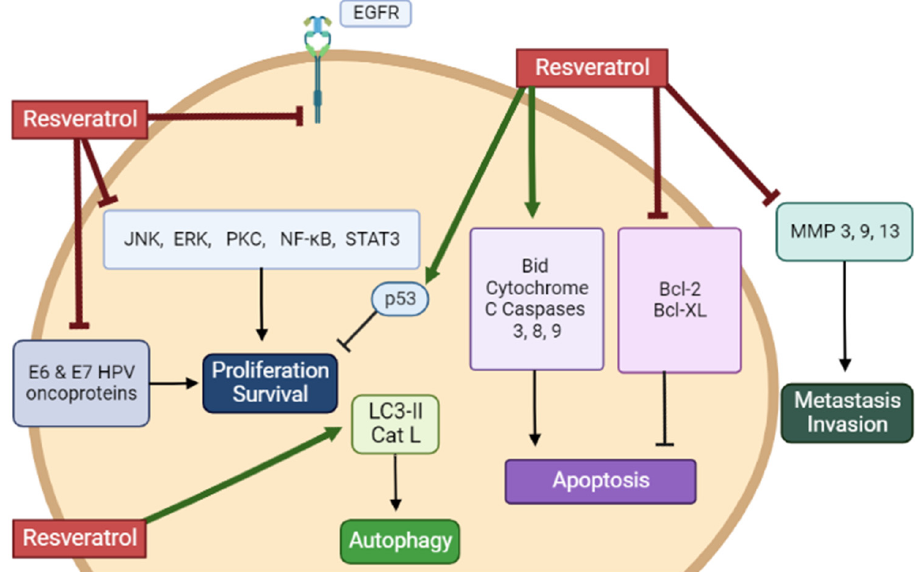
Figure 2. Summary of the effects of resveratrol in cervical cancer cells in vitro. RSV reduced pro- liferation and survival and induced apoptosis of cervical cancer cells. The figure, created using BioRender.com, is based on the data of the studies